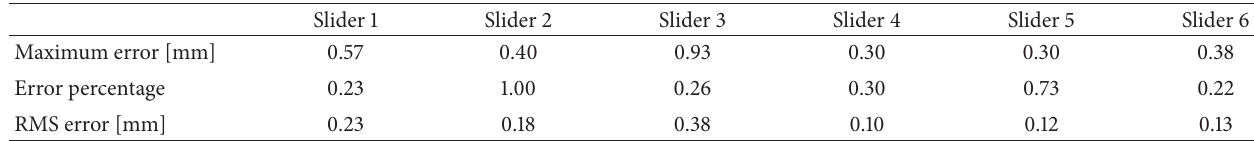
Table 5: Position errors of the